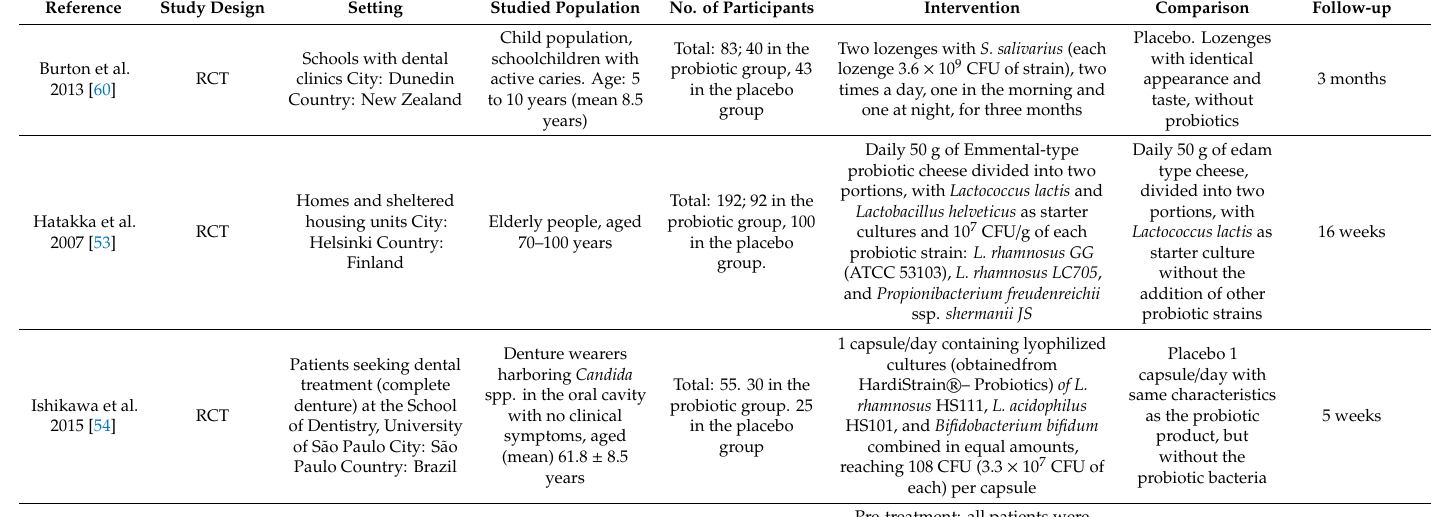
Table 2. Overview of the included studies. RCT—randomized controlled trial; CFU—colony-forming unit; OR—odds ratio; CI—confidence interval.